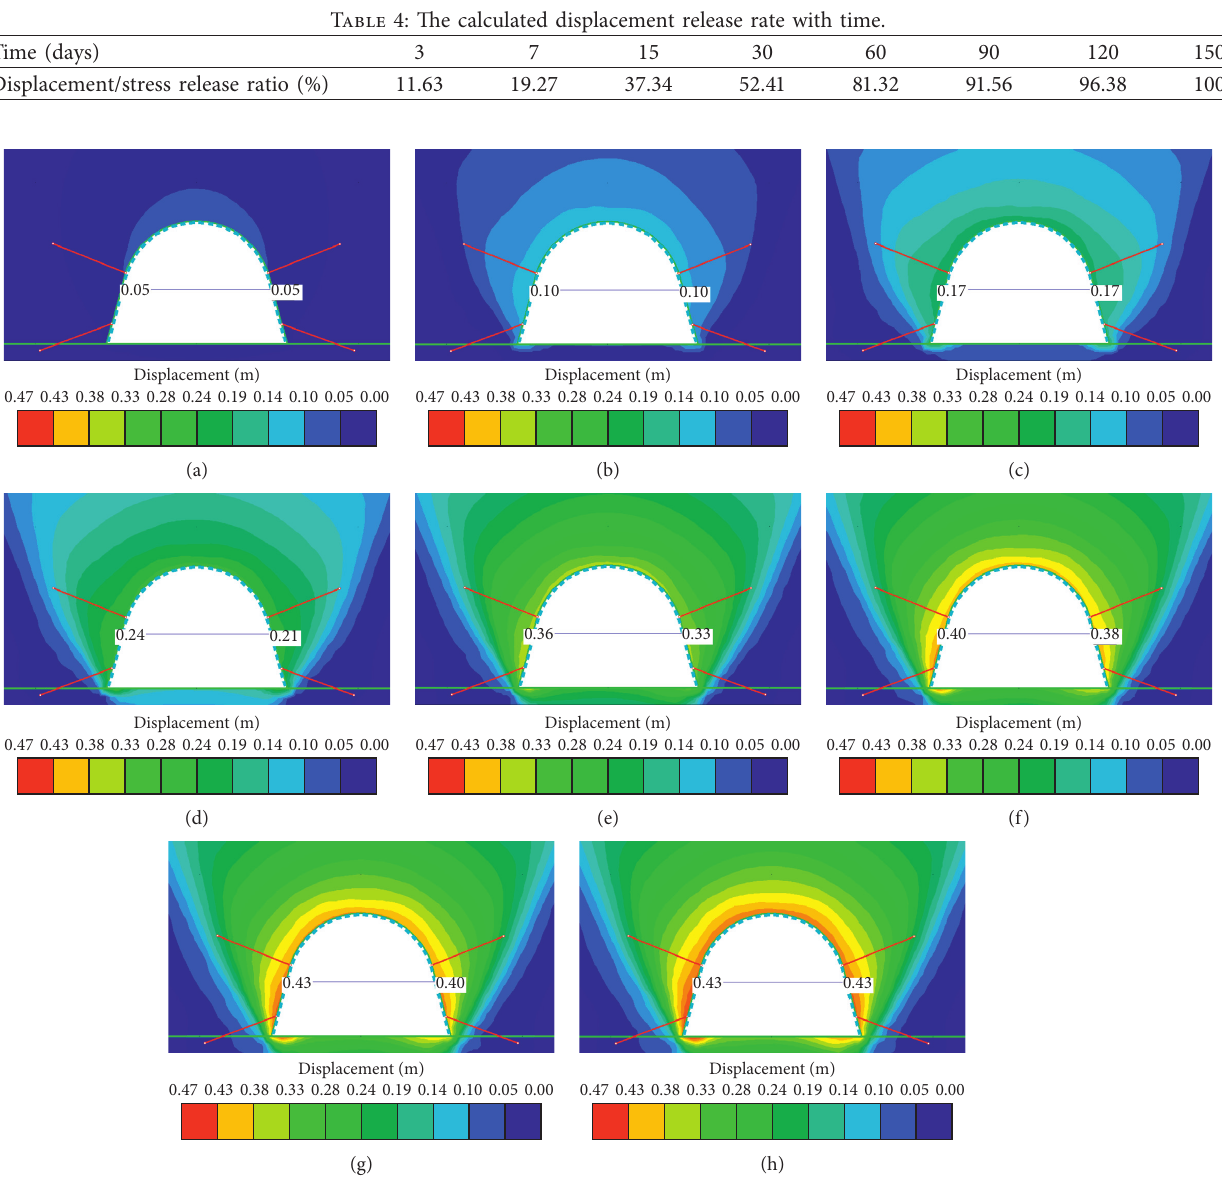
Figure 5: The calculated sidewall convergences from the 2D model with different stress release ratio. (a) 11.63%, (b) 19.27%, (c) 37.34%, (d) 52.41%, (e) 81.32%, (f) 91.56%, (g) 96.38%, and (h)